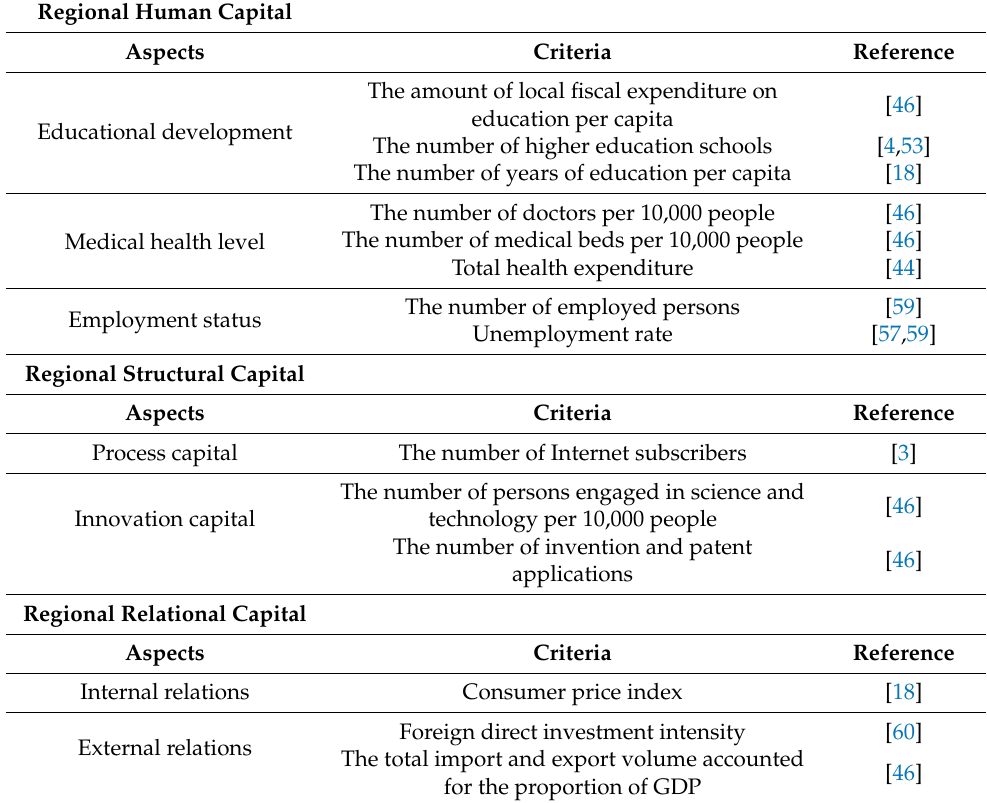
Table 1. Prototype decision